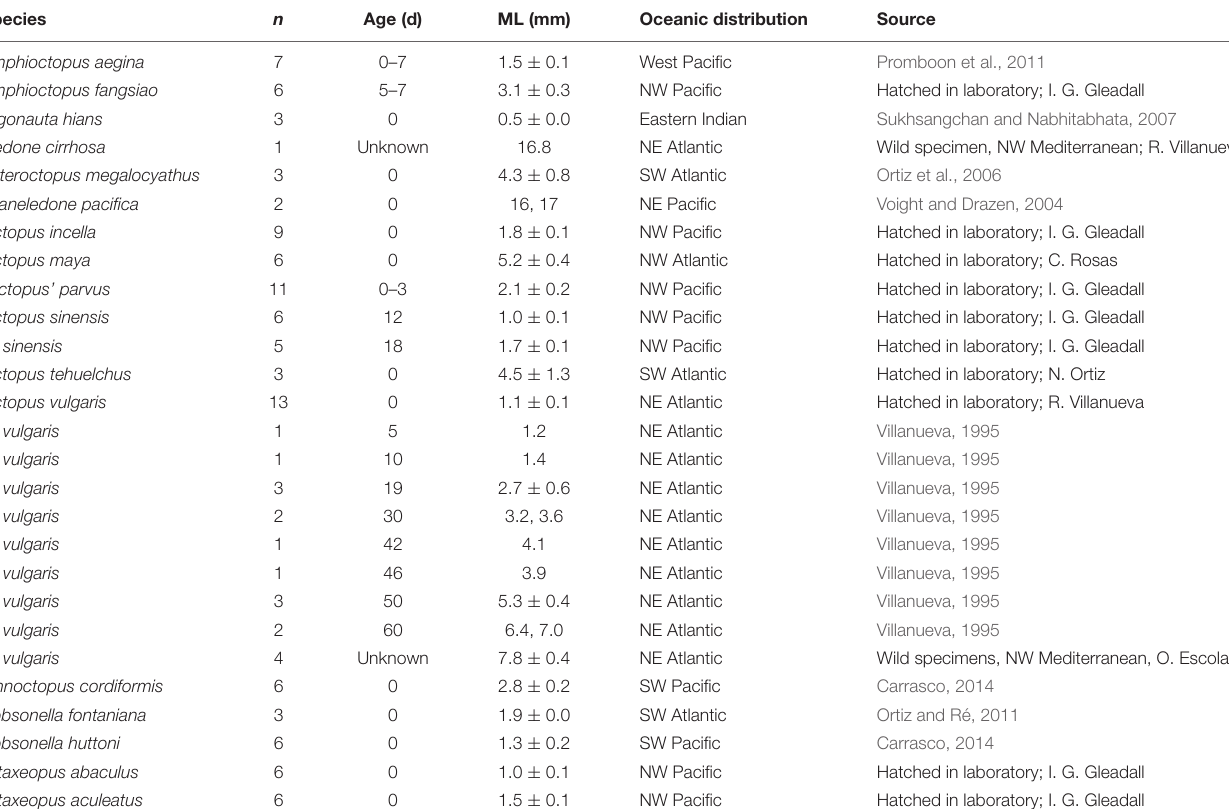
TABLE 2 | Material examined during the present study under